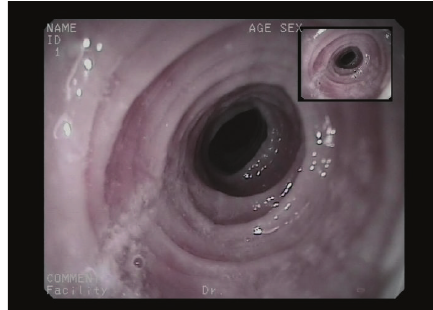
Figure 6: Six-month treatment later: cicatricial fibrous rings, no